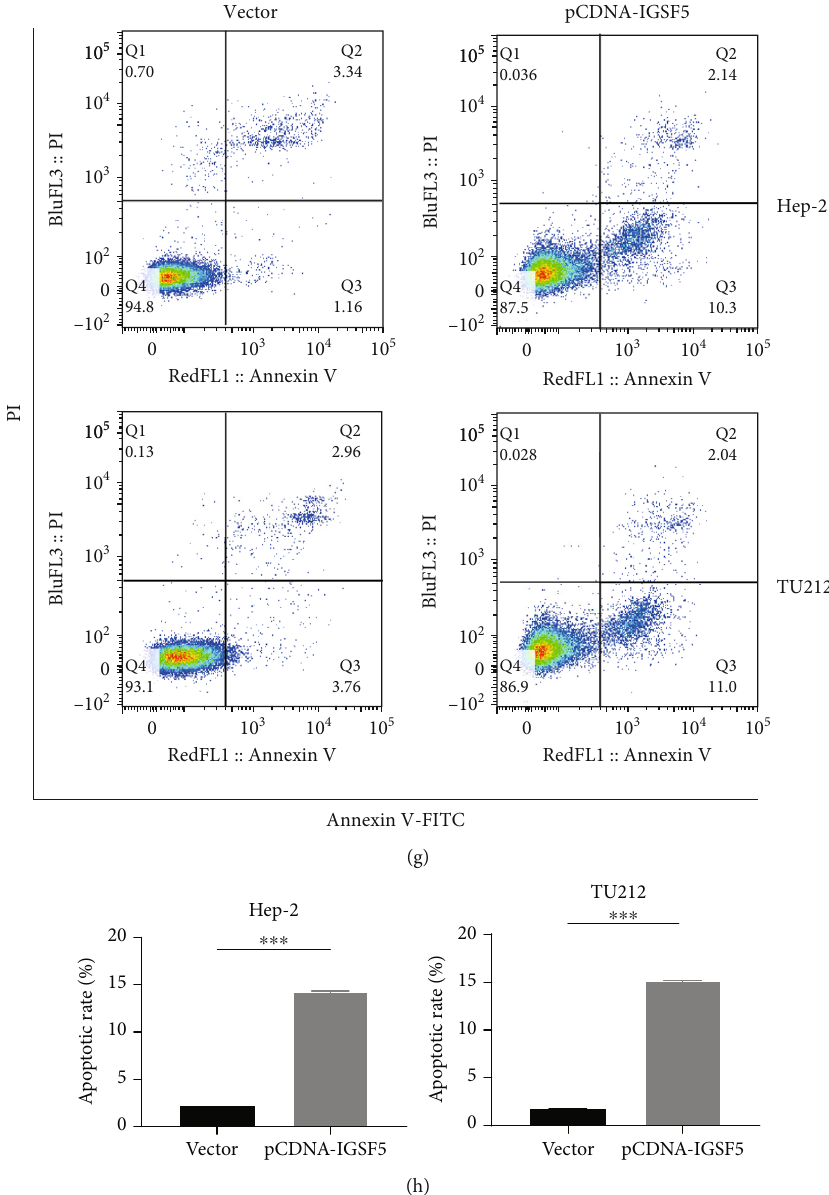
Figure 10: Overexpression of IGSF5 inhibits the proliferation of HNSCC cells. (a) IGSF5 had lower expression in HNSCC samples than in matched normal tissues from the TCGA database ( normal = 44 , tumor = 519 ). (b) IGSF5 in HPV-positive HNSCC tissues from the GSE65858 cohort was upregulated compared with that in HPV-negative tissues. (c) The expression of IGSF5 was detected by Western blot, and cells transfected with the IGSF5 overexpression plasmid di ff ered signi fi cantly between the IGSF5 overexpression (pCDNA-IGSF5) and control (vector) groups in Hep-2 and TU212 cells. GAPDH was used as an internal control. (d) Reduction in the proliferation ability of pCDNA- IGSF5 Hep-2 and TU212 cells compared with the control (vector) cells by the CCK8 assay. (e, f) Reduction in colony formation ability of pCDNA-IGSF5 Hep-2 and TU212 cells compared with the control (vector) cells by a colony formation assay. The bar graph indicates the number of colonies. (g, h) Cell apoptosis of pCDNA-IGSF5 Hep-2 and TU212 cells compared with the control (vector) was analyzed by fl ow cytometry. The rate of cell apoptosis is shown in the graphs. The results are presented as the mean ± s : d : and are representative of at least three independent experiments. ∗ p < 0 : 05 , ∗∗ p < 0 : 01 , ∗∗∗ p < 0 : 001 , and ∗∗∗∗ p < 0 : 0001 . ns: p > 0 : 05